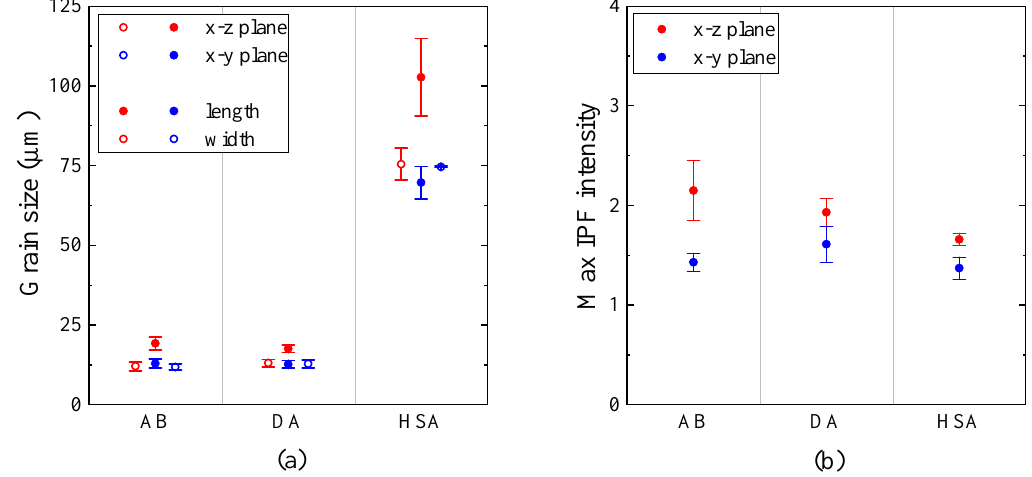
Figure 7. ( a ) Grain size ( b ) IPF texture intensity in different post-treatment